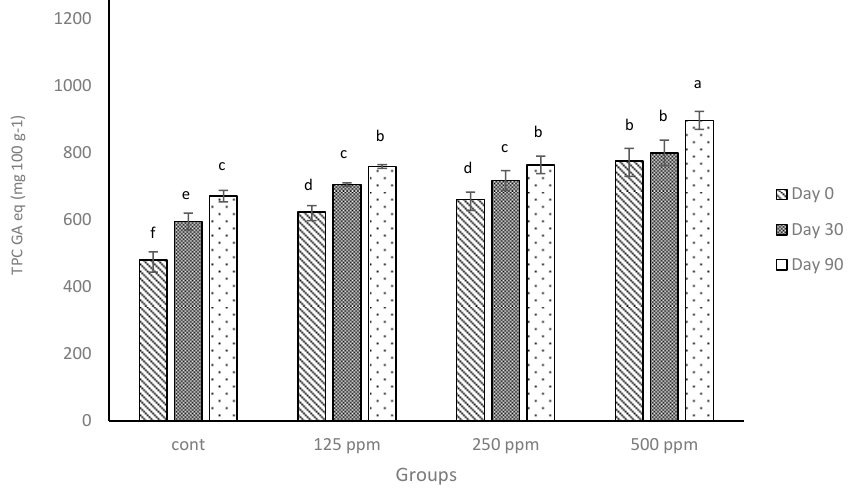
Figure 1. Total phenolic contents (TPC) of the control and full-fat cheeses enriched with different concentrations of free (+)-catechin over a 90-day ripening period reported in gallic acid equivalents (GA eq) per 100 g of cheese weight. Cont: control. Columns with different superscript letters differ significantly at p ≤ 0.05.